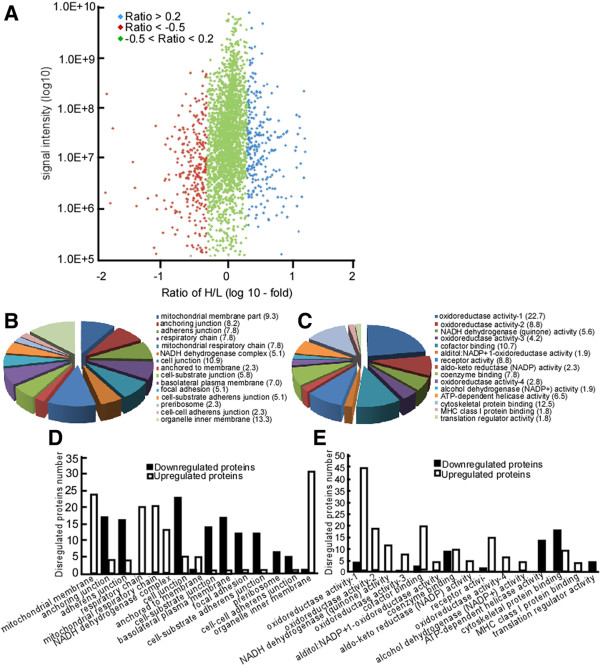
Proteome quantitation, significance, and classification analysis.A, signal intensities of all quantified proteins after DNP treatment are shown as a function of their fold change. Ratios of most proteins distributed around 1.0 (Log10 (ratio) = 0), indicating that whole proteins of the two groups of cells were mixed equally and 6-10B cells were fully labeled. The spread of the cloud was lower at high abundance, indicating that quantification is more precise, and their fold change level is indicated in blue, red, and green, respectively. To reduce test error, proteins at more than 2.0-fold or less than 0.5-fold and p < 0.05 were deemed to indicate significantly changed proteins induced by DNP treatment. Together, this gives quantifiable results for 371 proteins being significantly altered upon DNP, with 172 and 199 proteins being up- and down-regulated, respectively. The 15 most abundant terms of component (B) and function annotation in disregulated proteins (C) are shown. As each protein is generally assigned to more than one term, the percentage of proteins in each term is shown instead of the total number to avoid redundancy. Number distribution of the 15 most abundant terms for up-regulated or down-regulated proteins (D). Oxidoreductase activity-1, 2, 3, and 4 represent respectively oxidoreductase activity, oxidoreductase activity acting on NADH or NADPH, oxidoreductase activity acting on the CH-CH group of donors, and oxidoreductase activity acting on the CH-CH group of donors, NAD or NADP as acceptor (E).